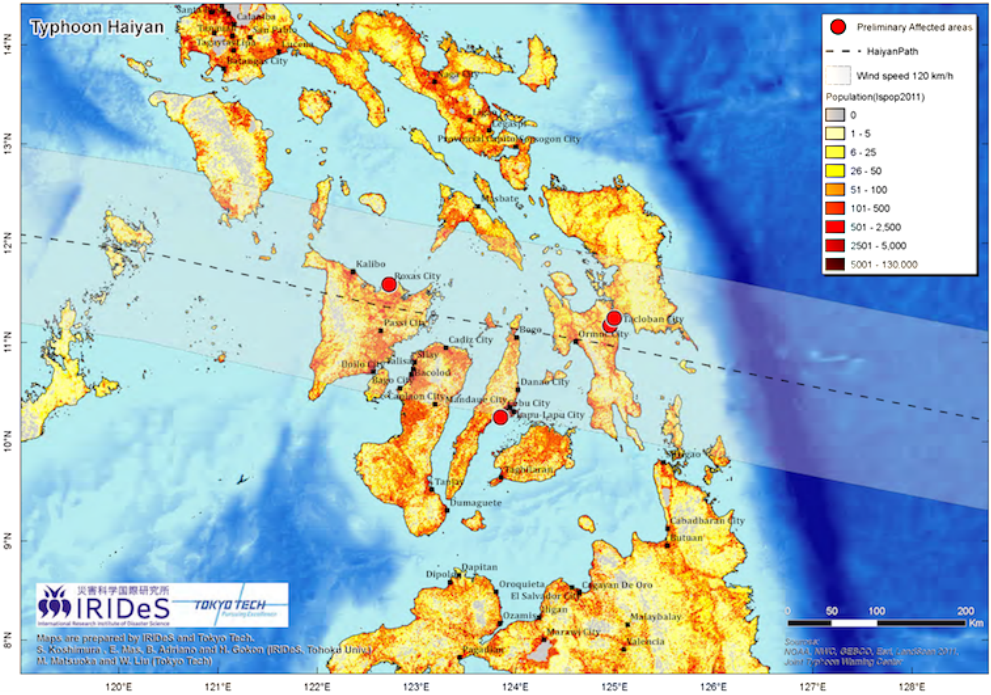
Figure 1. Track of Super Typhoon Haiyan through the Philippines Area of Responsibility (PAR) overlaid on the LandScan population data. Almost 4 million families were affected across 44 provinces of the Eastern Visayas.